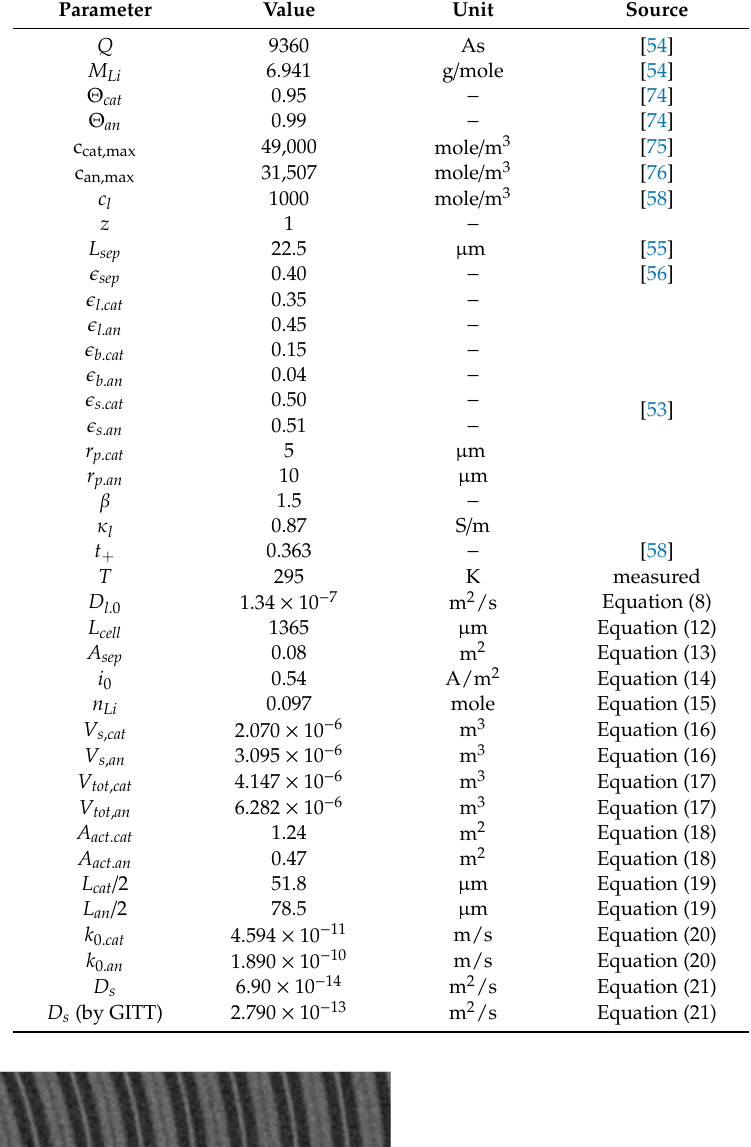
Table 3. Complete list of estimated electrochemical parameters for modeling a Samsung ICR18650-26F 2.6Ah cell. Values below the dotted black line were calculated in the present paper.